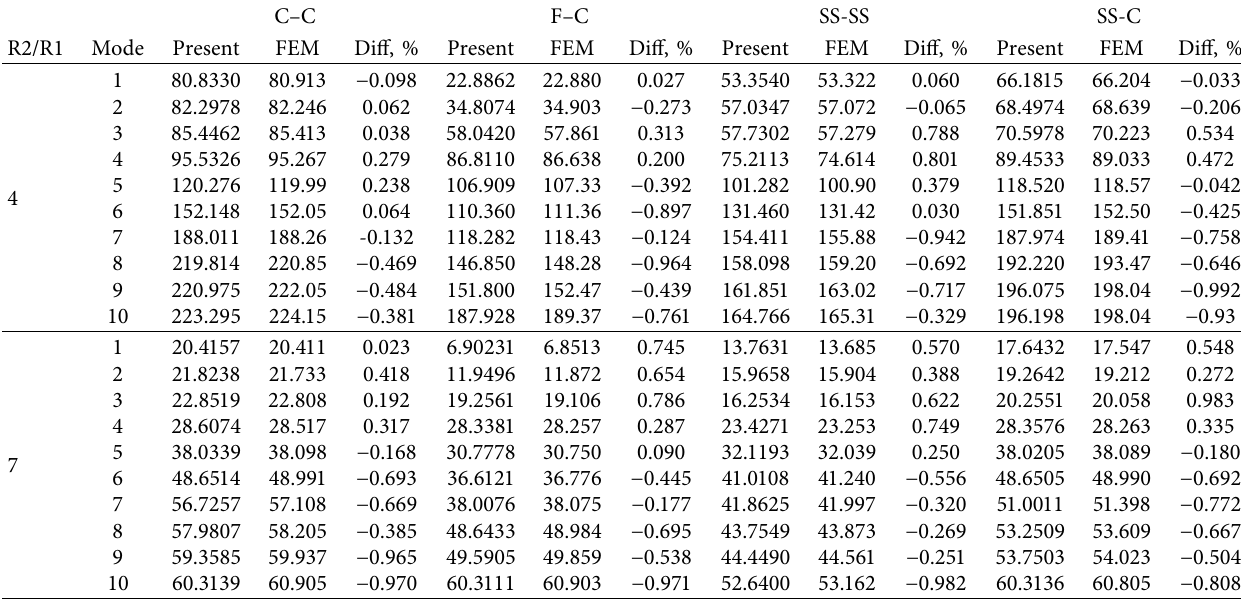
Table 7: Comparison of the first ten natural frequencies for laminated composite annular plate with variable thickness and radius ratio R2/